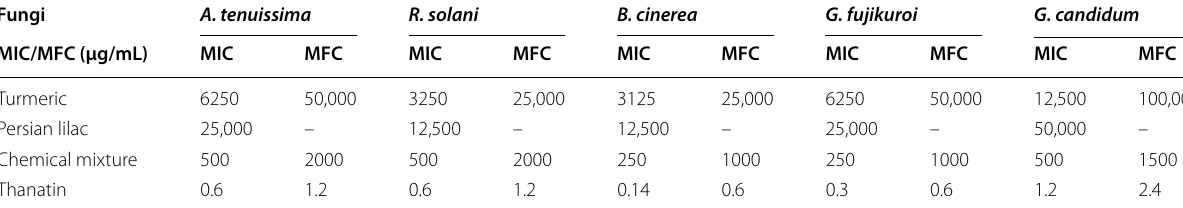
Table 2 Determination of MIC and MFC for different treatments tested against five fungal plant pathogen